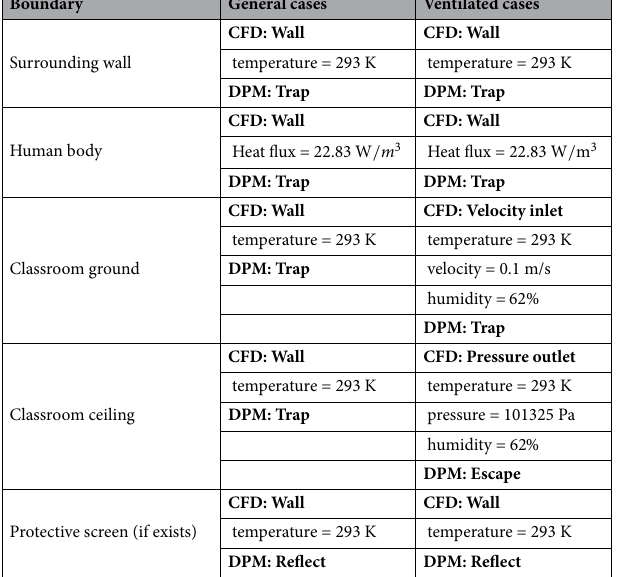
Table 2. CFD and DPM selections for computation.